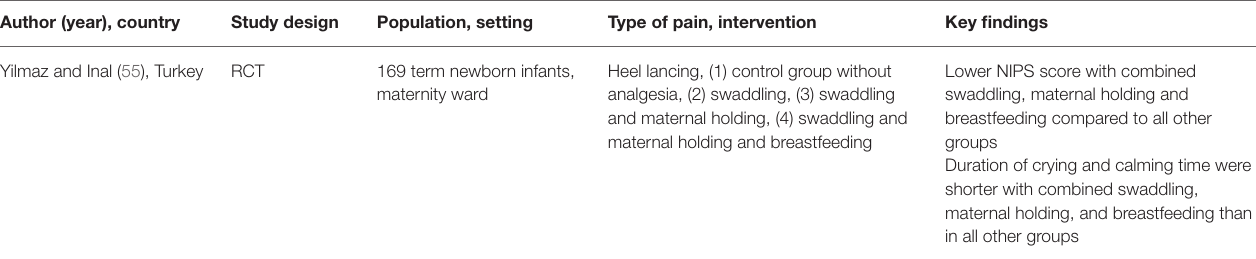
TABLE 2 | Evidence for parent-delivered interventions: expressed breastmilk. Author (year), country